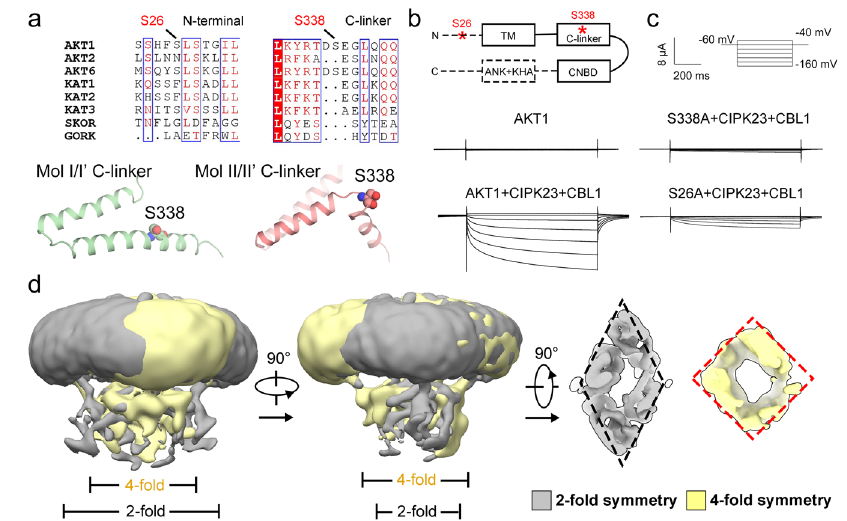
Fig. 3 | Phosphorylation triggered intra-molecular rearrangement of AKT1. a Structural mapping of the identi fi ed phosphorylated residues Ser26 and Ser338. A sequence alignment of predominant K + channels in Arabidopsis is shown. Ser26 is located at the N-terminus of AKT1. Ser338 is mapped to the kink that differentiates the two conformations of C-linkers. b A diagram to show the domaindistributionofphosphorylationsites. c Whole-cellcurrentsofmutations